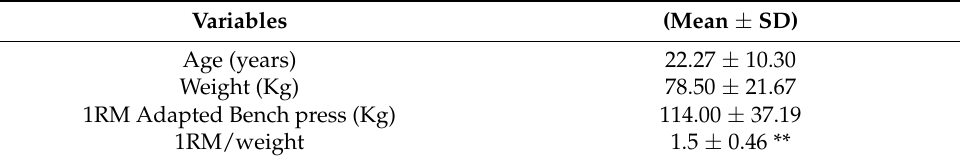
Table 1. Sample Table 1. Sample characterization.